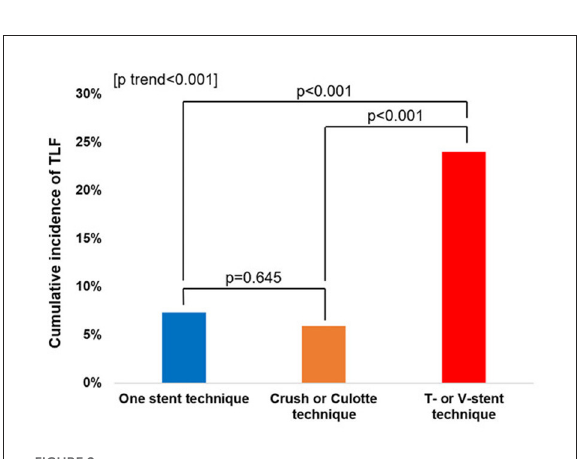
FIGURE2 Incidence of target lesion failure (TLF) for one-stent, T-stent, V-stent, and crush or culotte